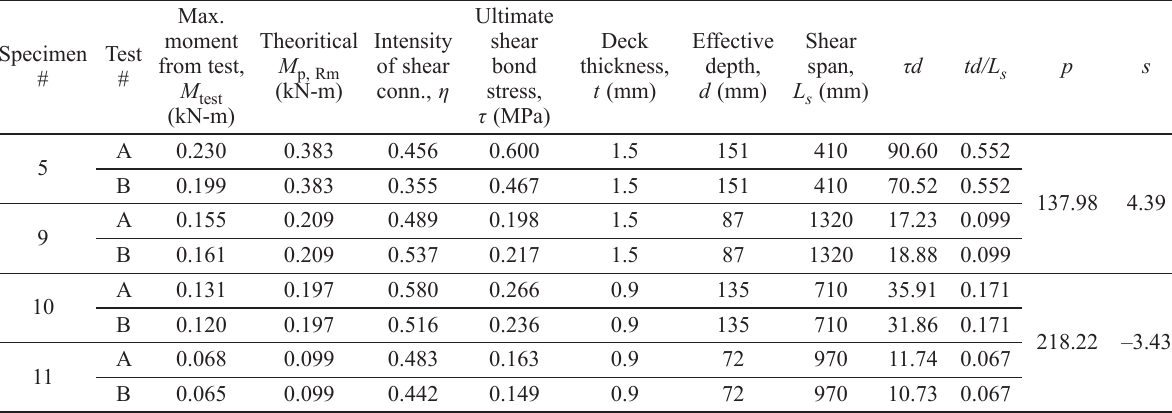
Table 3. Design parameters according to the PSC method with the application of the shear bond-slenderness equation Max. Specimen Test # #